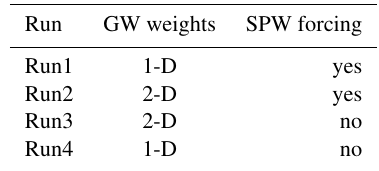
Table 1. Overview on the model runs and their